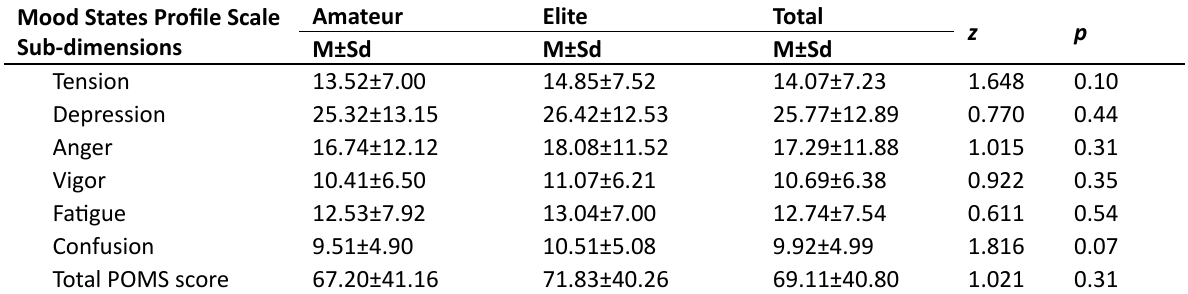
Table 4. Analysis of emotional eating status of the athletes during the social isolation period Emotional Eating Scale Sub-dimensions